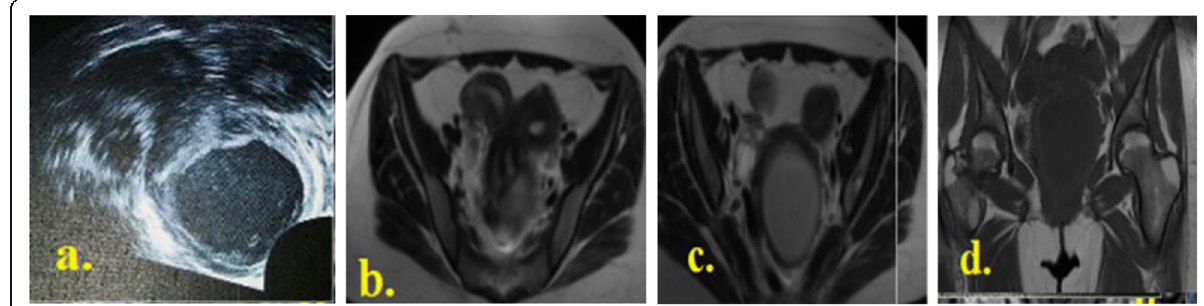
Fig. 8 A 23-year-old married female patient. a 3D TVS showing complete bicorporeal with two cervices and two vaginas (class U3b). b MRI coronal oblique T2 showing two uterine bodies and two cervices. c Coronal T2 oblique showed left vaginal lesion high signal in T2 and low signal in T1 ( d )